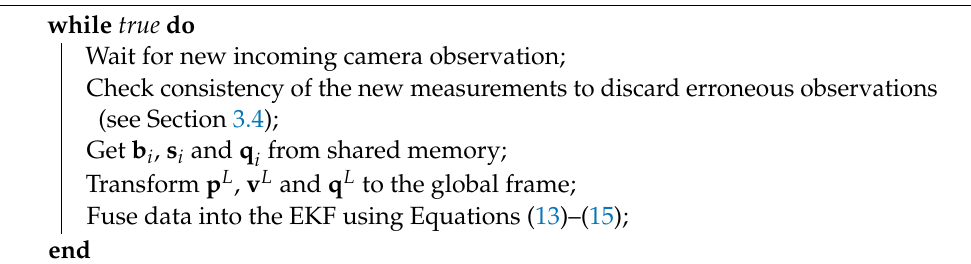
Algorithm 3: Camera threads (one for each